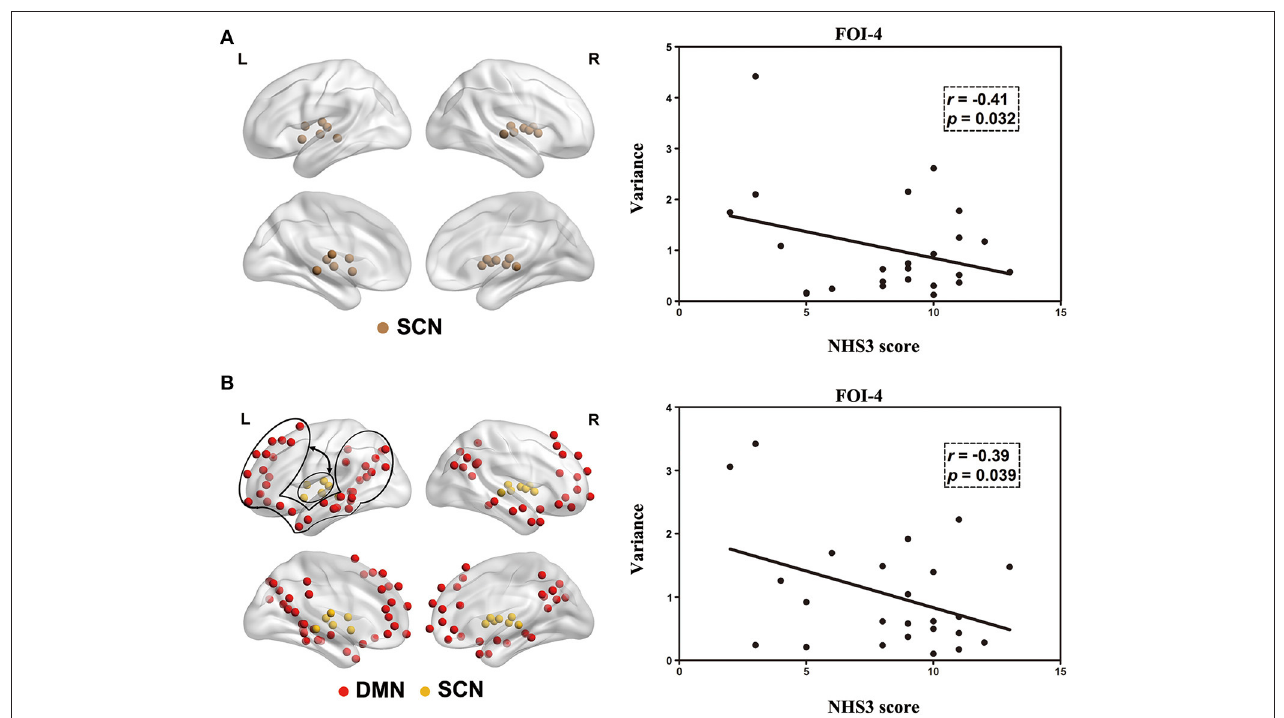
FIGURE 6 | Correlation between the NHS3 score and intra-RSN dynamics (A) and inter-RSN dynamics (B) in patients with JME. Double arrows represents inter-RSN dynamics between two circled